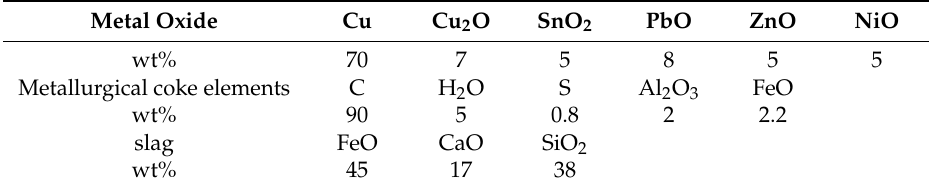
Table 1. Metal oxides, metallurgical coke, and slag composition utilized in the input, as publihsed by Ghodrat et al. [25].